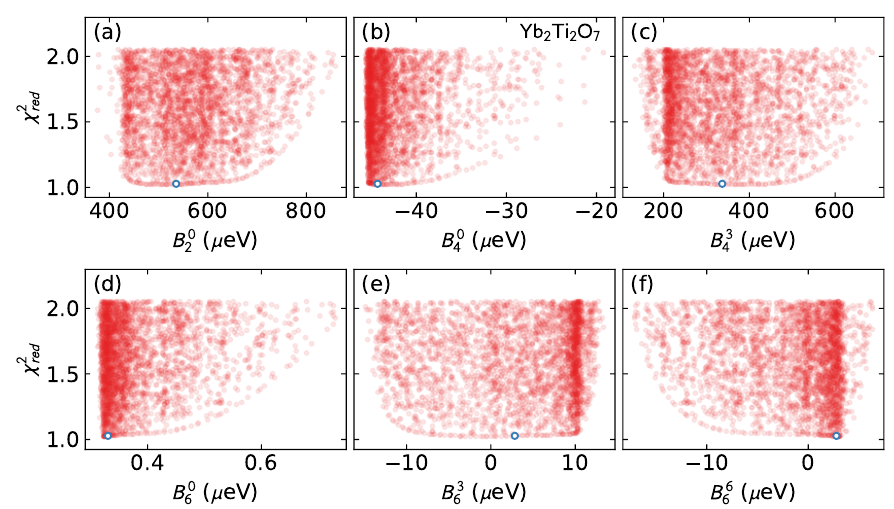
Figure 2: χ 2 for the simulated Yb Ti O data in Fig. 1. Each red point is a solution 2 2 7 red within ∆ χ 2 < 1, and each panel shows a fitted CEF parameter. The “real” solution is shown with the small blue circle. The x axis domain defines the uncertainty in each CEF